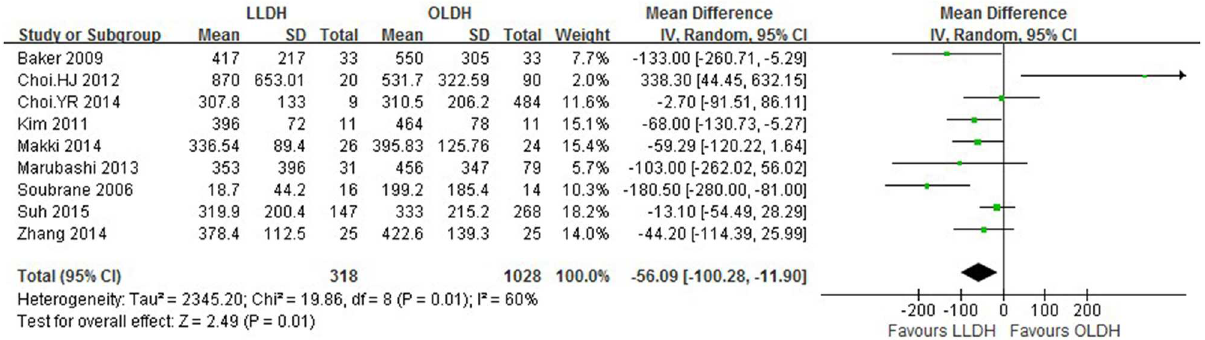
Fig 3. Forest plot displaying the results of the meta-analysis on intraoperative blood loss.